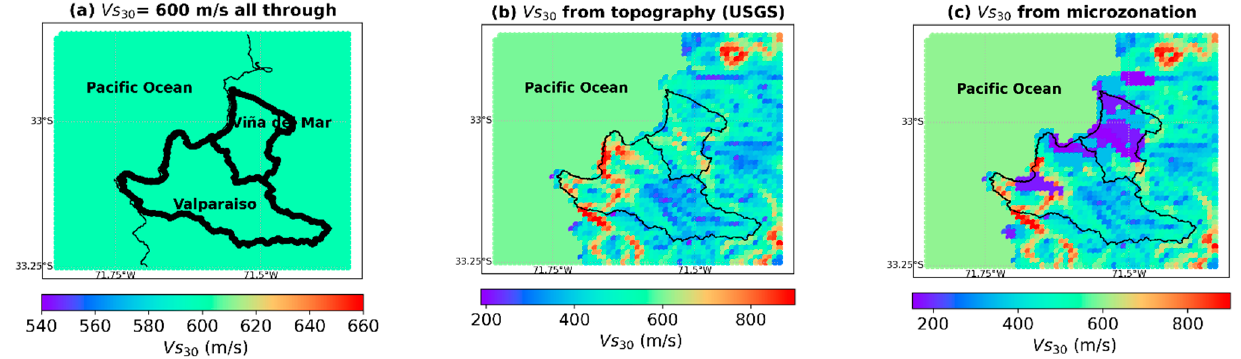
Figure 13. Distribution of the Vs 30 values in Valparaíso and Viña del Mar ( a ) considering 600 m/s uniformly distributed throughout, ( b ) as proposed by the USGS [94], and ( c ) the combination of the former and the values reported in the seismic microzonation [95].